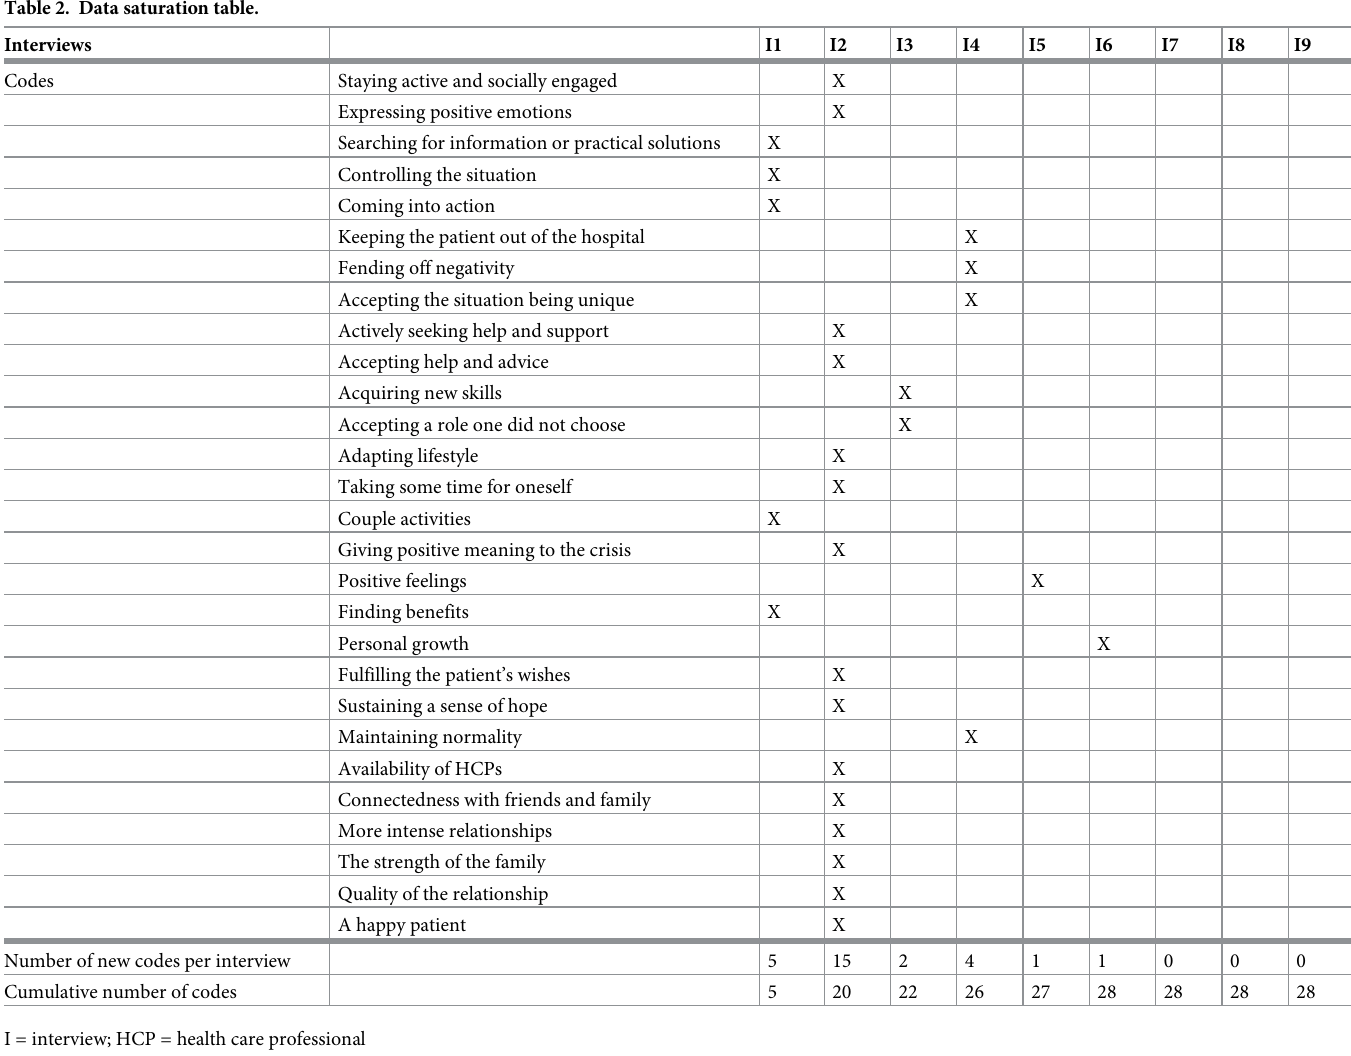
Table 2. Data saturation